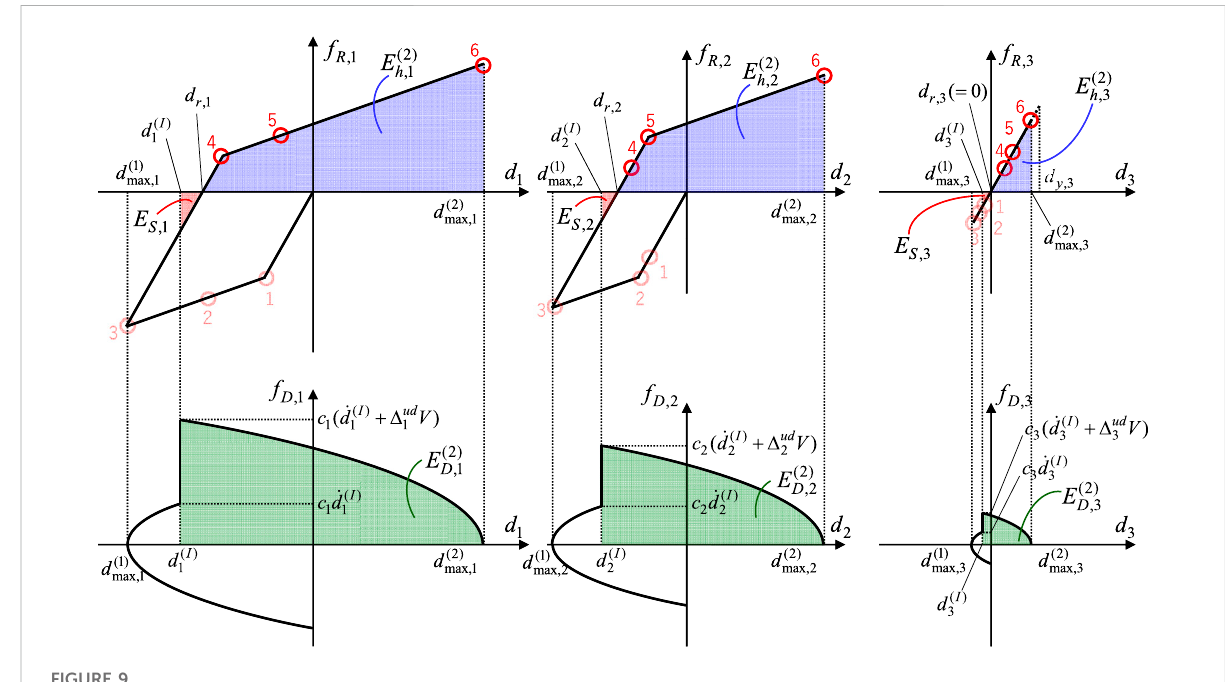
FIGURE 9 Evaluation of maximum interstory drifts d ( 2 ) max after the second